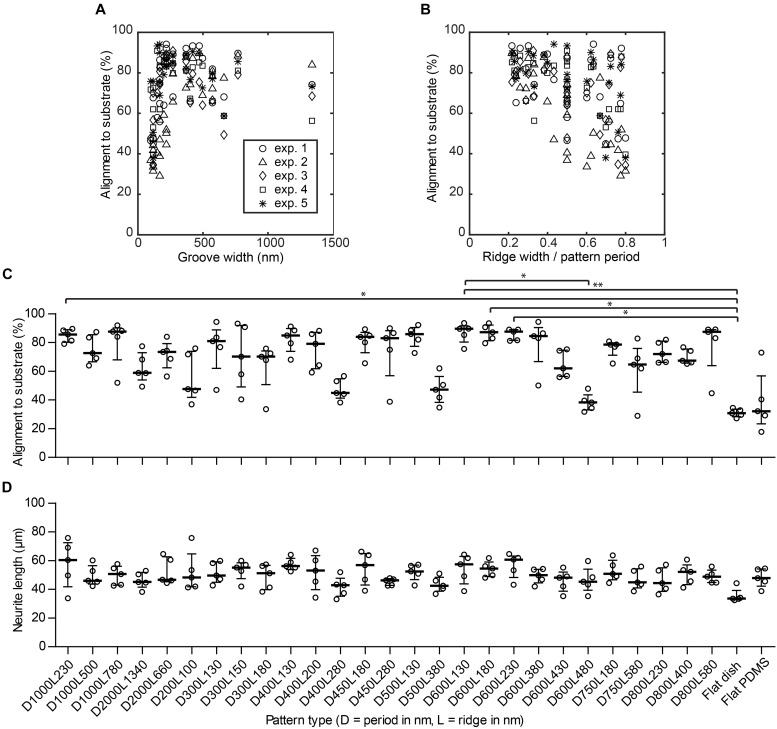
Nanogrooved patterns affect neurite alignment but not neurite length. (A) Scatter plot showing the percentage of alignment depending on the groove width of the nanogrooved patterns. (B) Scatter plot showing how alignment of neurites is affected by the ratio of pattern ridge width to pattern period size. The legend in (A) shows markers for data of each experiment for plots (A–B). (C) The percentage of neurites from differentiated SH-SY5Y cells aligned to the underlying nanogrooved PDMS substrate or flat substrate (indicated underneath D) in an image as analyzed by neuronal cell feature detection in HCA-Vision combined with a Frangi vesselness algorithm in MATLAB. At isotropic distribution of neurites, alignment will be 33%. Data points shown are alignment percentages per substrate type from n = 5 experiments. Bars indicate median ± IQR. Statistically significant differences were measured using the Kruskal–Wallis non-parametric test with post hoc Dunn’s multiple comparison test at a significance level of 0.05. ∗Represents P < 0.05 and ∗∗represents P < 0.01. (D) The neurite length for neurites of differentiated SH-SY5Y cells per substrate type. Data points shown are mean neurite lengths per substrate type from n = 5 experiments. Bars indicate median ± IQR. Statistically significant differences were not found using the Kruskal–Wallis non-parametric test with post hoc Dunn’s multiple comparison test at a significance level of 0.05.